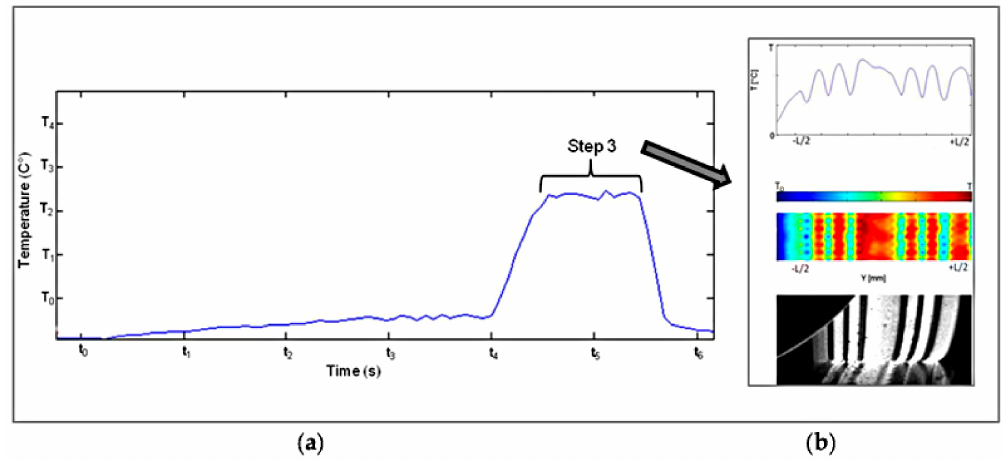
Figure 18. Experimental data, tire rolling on a steel drum, loading with 200 kN, velocity up to 114 km/h, skidding angle = 6 ◦ , ( a ) global temperature evolution of tire tread during the four steps of testing (Figure 3), ( b ) temperature of the contact zone, infrared camera recorded during 1.5 s of the step 3.